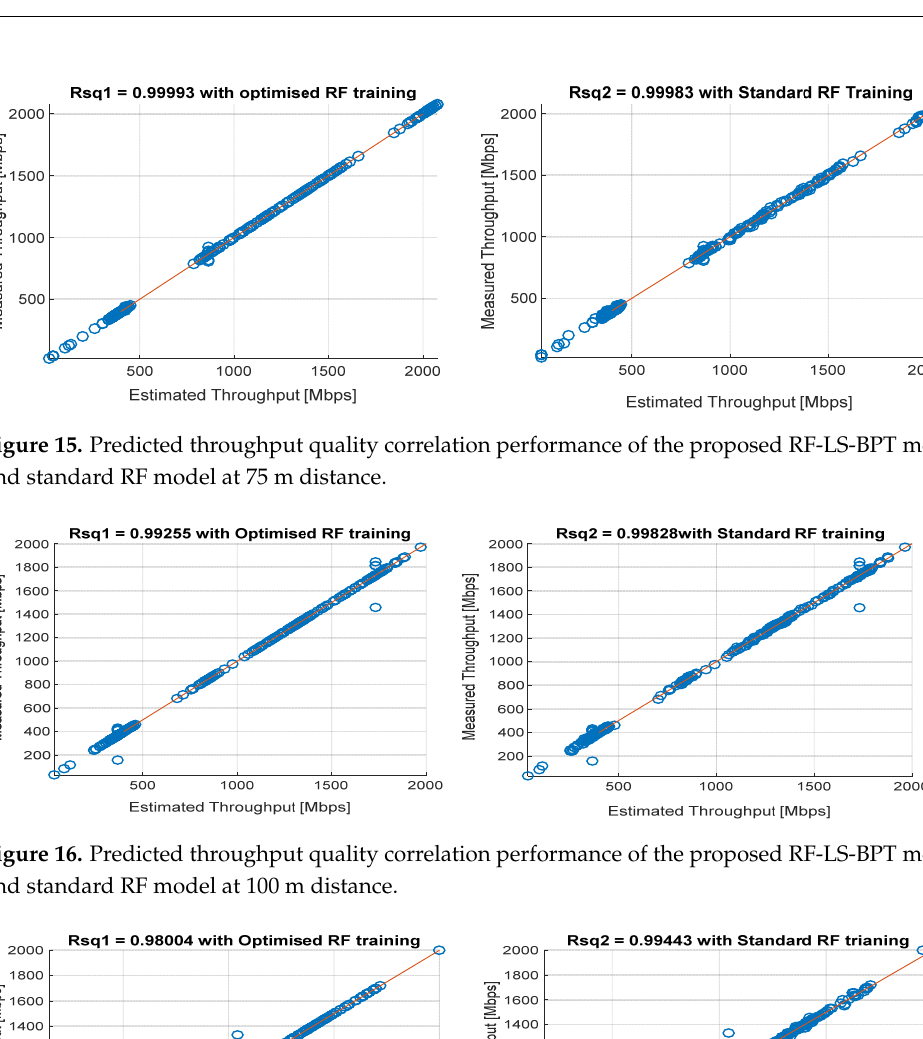
Figure 14. Predicted throughput quality correlation performance of the proposed RF-LS-BPT model and standard RF model at 50 m distance.